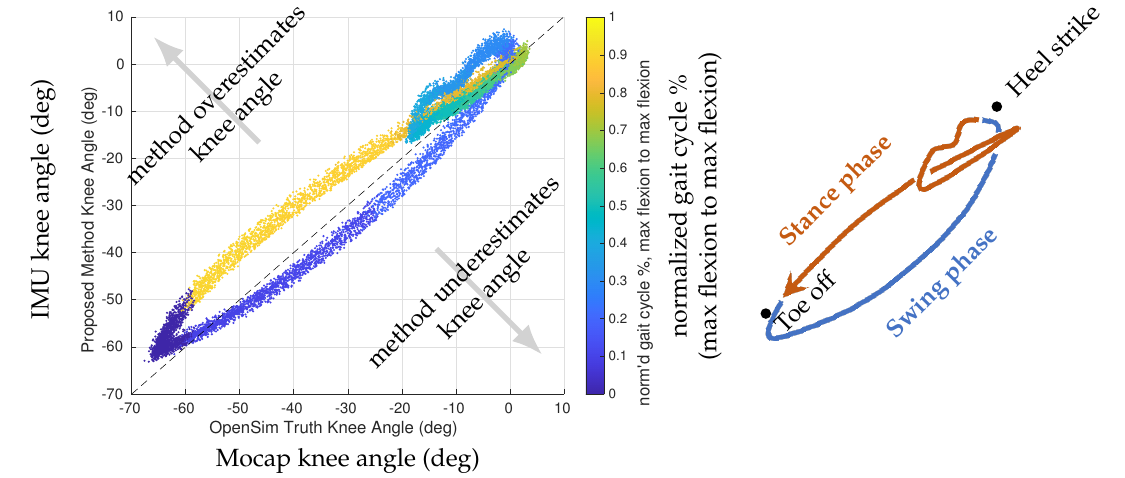
Figure 3. ( Left ) Subject 10 IMU vs. mocap left knee angle, colored by temporal location of the gait cycle. Gait cycle is defined to start and end at knee maximum flexion (approximately toe off) of the mocap angle. An ideal estimate would lie along the reference line with unity slope, shown as a black dotted line. Note the top-right corner of the data, where a disturbance between the heel strike and toe strike phase is observed. ( Right ) An approximate stylized representation of the gait cycle data, with swing (blue) and stance (orange) phases labeled, along with toe off and heel strike